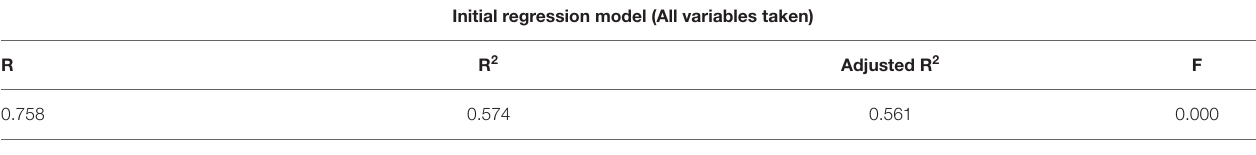
TABLE 1 | Parameters of test regression model and final regression model. Initial regression model (All variables